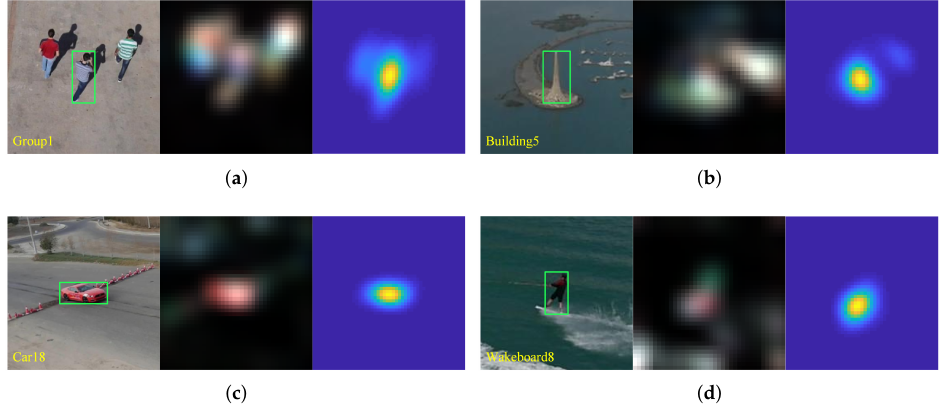
Figure 3. Some visual results of the object saliency awareness. ( a ) Group1. ( b ) Building5. ( c ) Car18. ( d ) Wakeboard8. The first column is the input image patch centered on the target (with a green bounding box). The second and third columns present the saliency map and its response map, respectively. All these examples are from the UAV123@10fps [45]